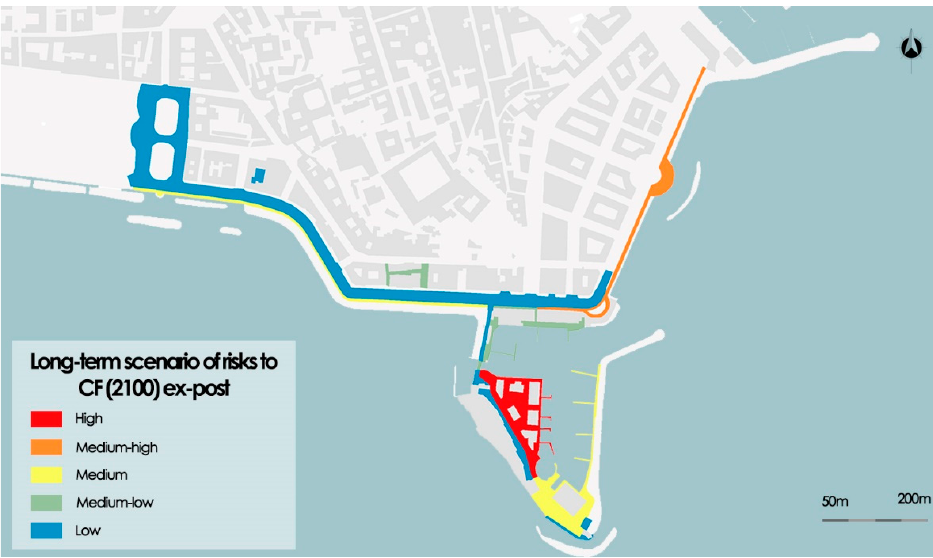
Figure 13. Long-term scenario of risk to coastal flooding phenomenon (2100) after the application of medium-hard NBS.